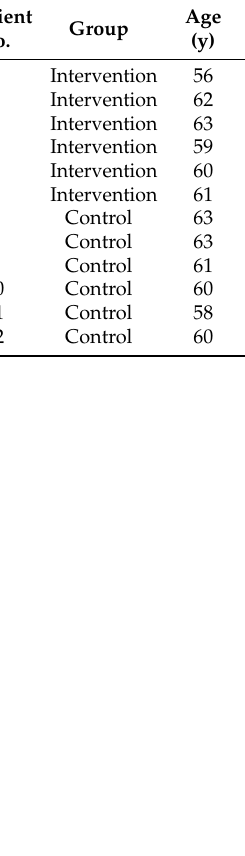
Table 2. Baseline characteristics of the participants.